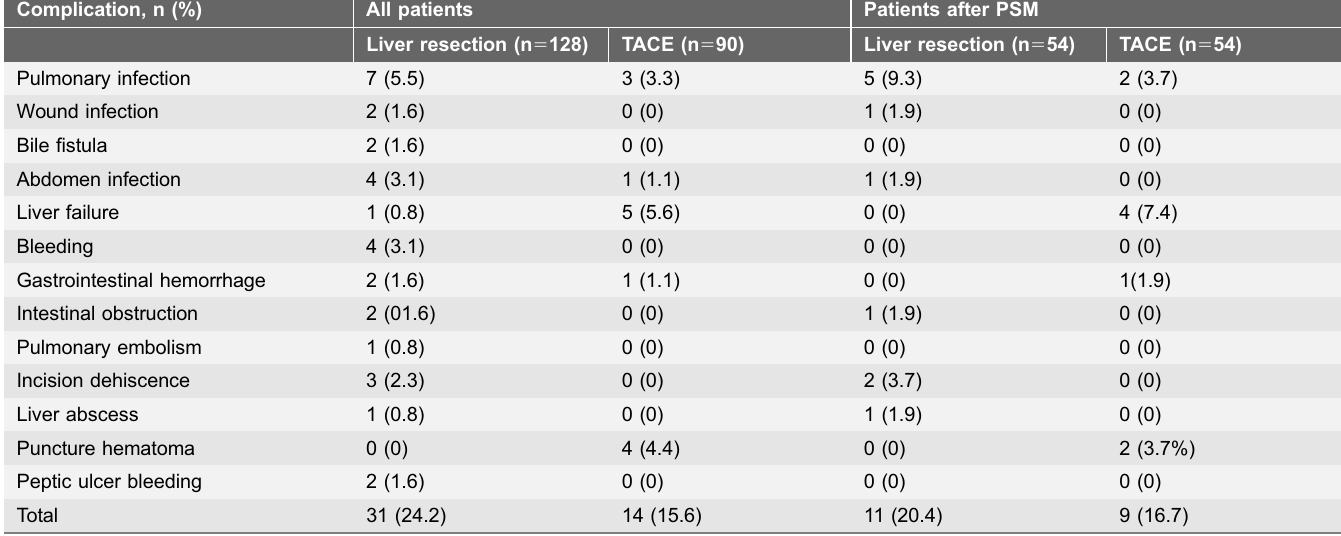
Table 4. Postoperative complications of all patients and patients after propensity score matching